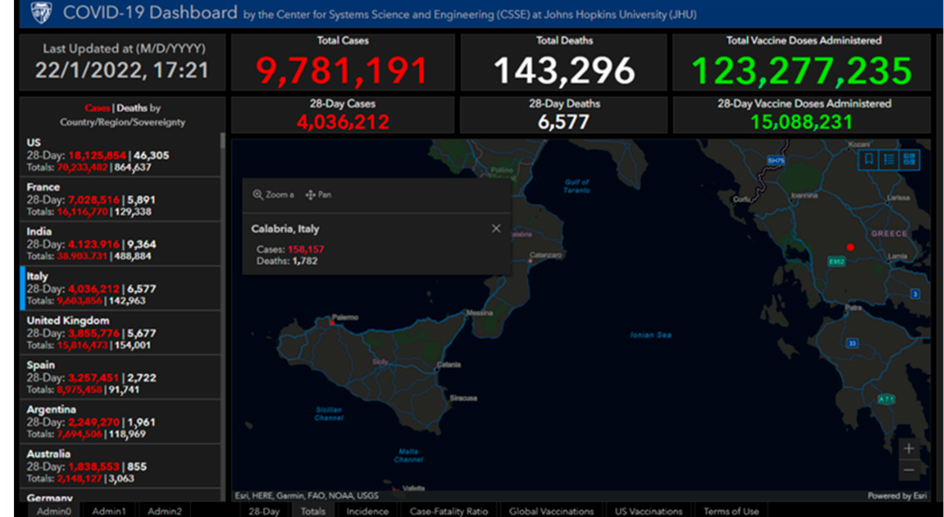
Figure 1. Adapted from COVID-19 Map–Johns Hopkins Coronavirus Resource Center (accessed on 22 January